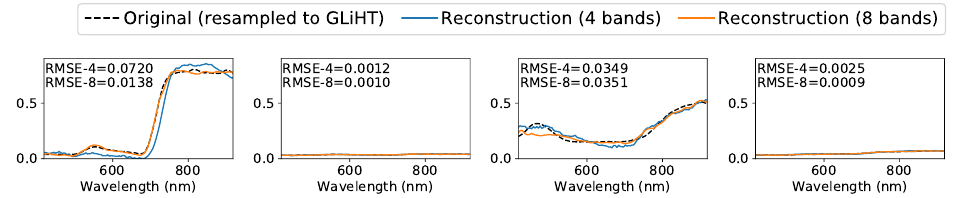
Figure 15. Reconstructions of AVIRIS spectra using G-LiHT trained models. (Left to right) the worst reconstruction with 4 bands, the best reconstruction with 4 bands, the worst reconstruction with 8 bands, and the best reconstruction with 8 bands. RMSE-4 and RMSE-8 are RMSE between original spectra and reconstructions from 4 bands and 8 bands